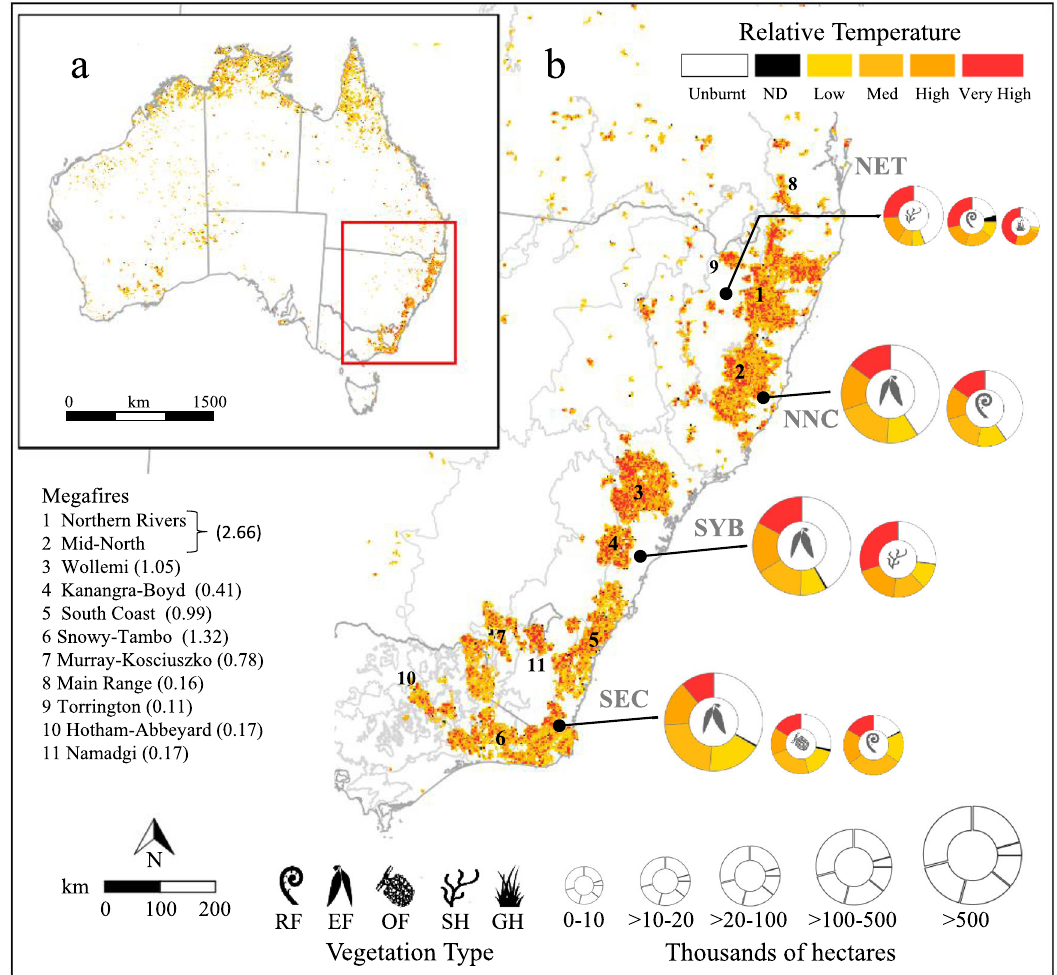
Fig. 1 Extent and temperature of bush fi res between 1 July 2019 and 11 February 2020 and impacts on vegetation. a Australia, with study area as red inset, and b the south-eastern Australian mainland study area, reconstructed from satellite hotspot data (see ‘ Methods ’ ). Fire temperature was scaled between minimum and maximum temperatures to produce a relative fi re temperature ( T R ; Low = 0 – 0.25, Med = >0.25 – 0.50, High = >0.50 – 0.75, Very High = >0.75 – 1.0, ND = no data; see ‘ Methods ’ ). Broad vegetation types are: RF = Rainforest and Vine Thickets; EF = Eucalypt Forests and Woodlands; OF = Other Forests and Woodlands, SH = Shrublands and Heathlands; GH = Grasslands, Herblands, Sedgelands and Rushlands. The total area of vegetation types and proportions burnt in each of four coastal or near-coastal bioregions (NET = New England Tablelands, NNC = NSW North Coast, SYB = Sydney Basin, SEC = South East Corner), and in each relative temperature category are shown. The bracketed value after each mega fi re is the fi